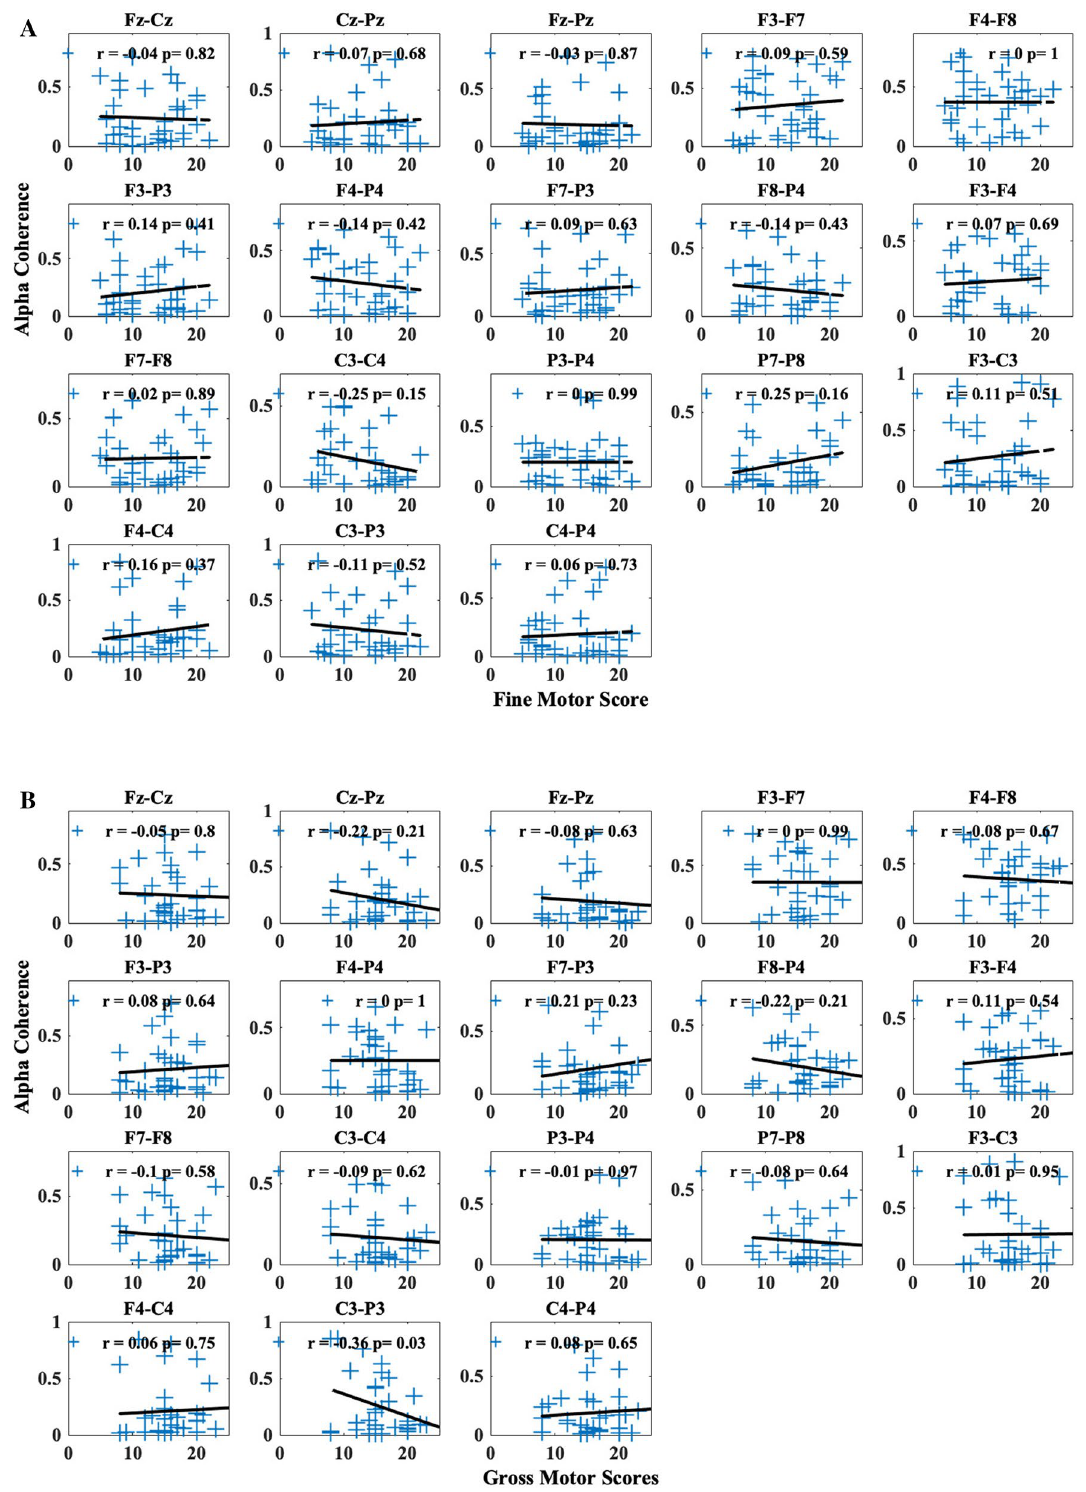
Figure 5. Change in mean alpha coherence along (6–9 Hz) ( A ) fine motor and ( B ) gross motor scores from Bayley Scales of Infant and Toddler Development, 3rd edition for each electrode pair. Within each subplot, blue crosses represent mean alpha coherence for each session and dashed lines represent the least-squares fitted lines. The r and p values are the results from the correlation